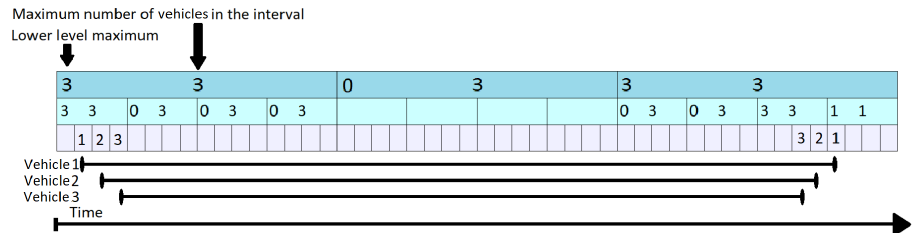
Figure 7. KI Tree—Initial State.